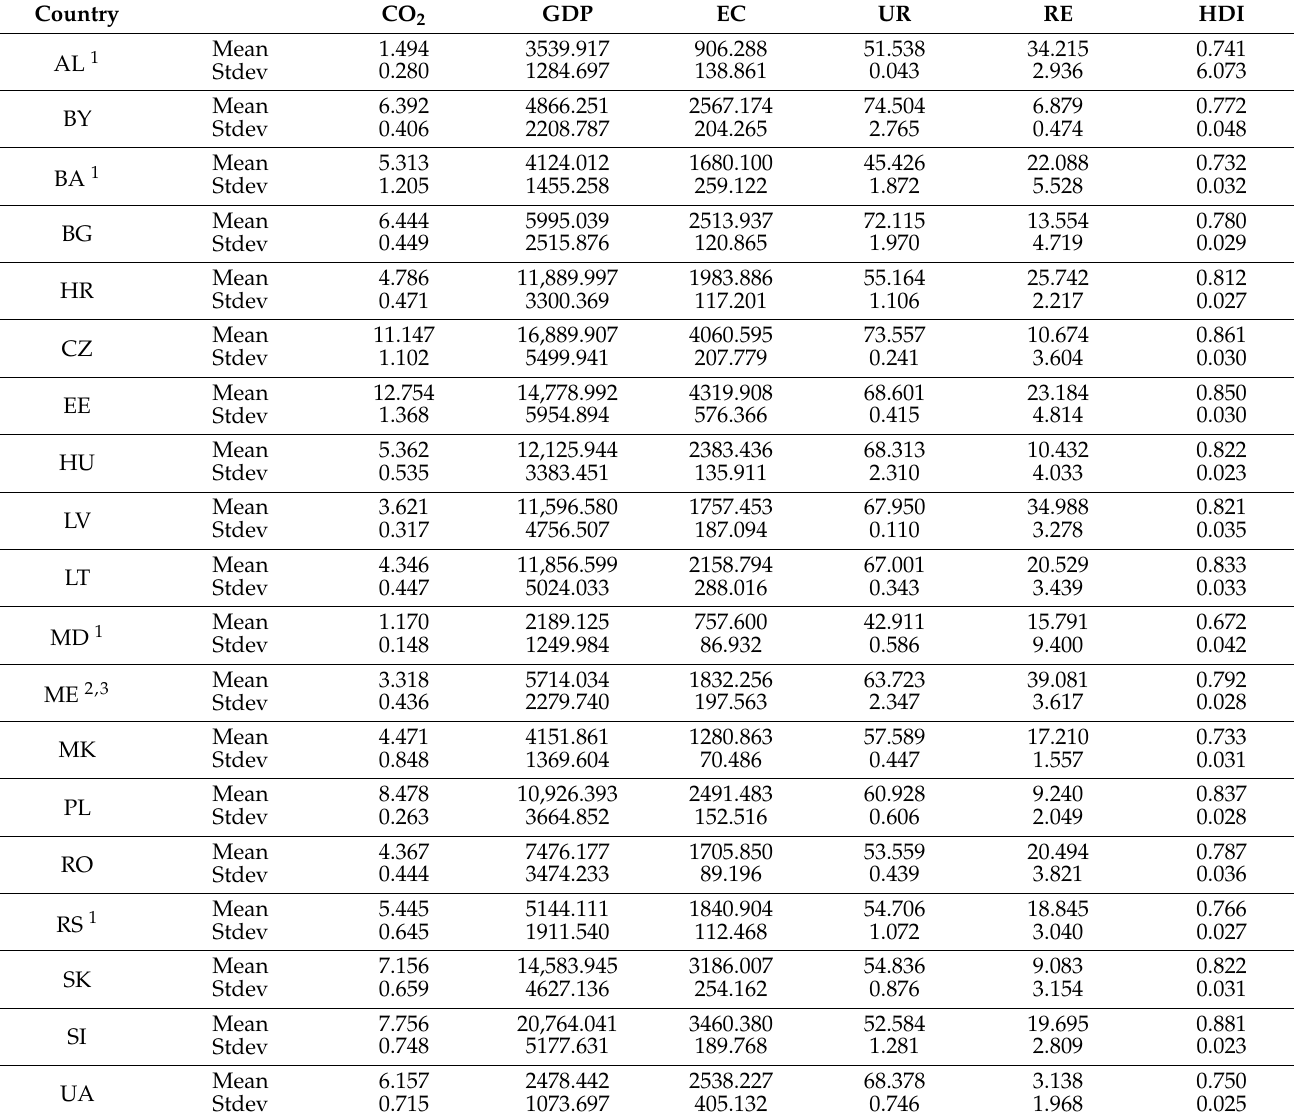
Table 1. Summary statistics of time-series